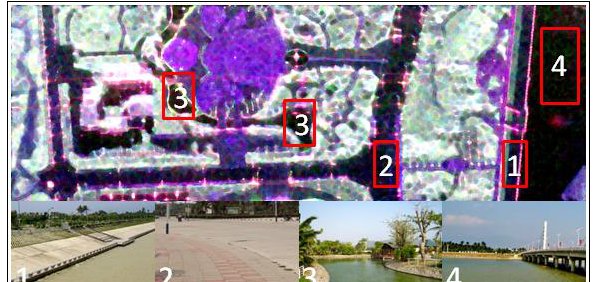
Figure 14. The PAULIRGB image of the test site B and the corresponding ground truth